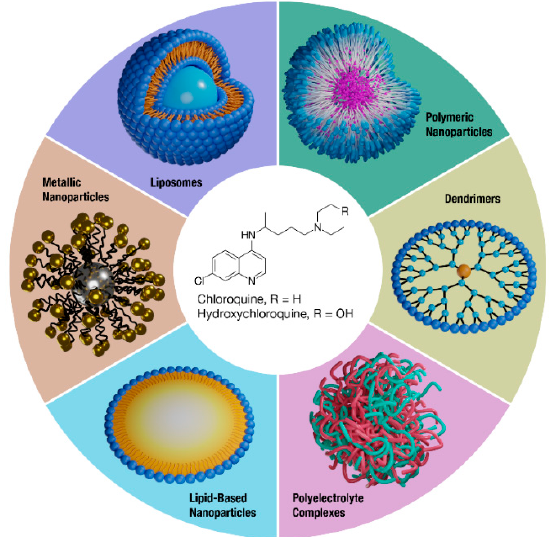
Figure 1. Nanomedicine formulations of CQ and HCQ. A variety of nanotechnology platforms are being explored in the reformulation efforts of improving the overall safety and efficacy of CQ and